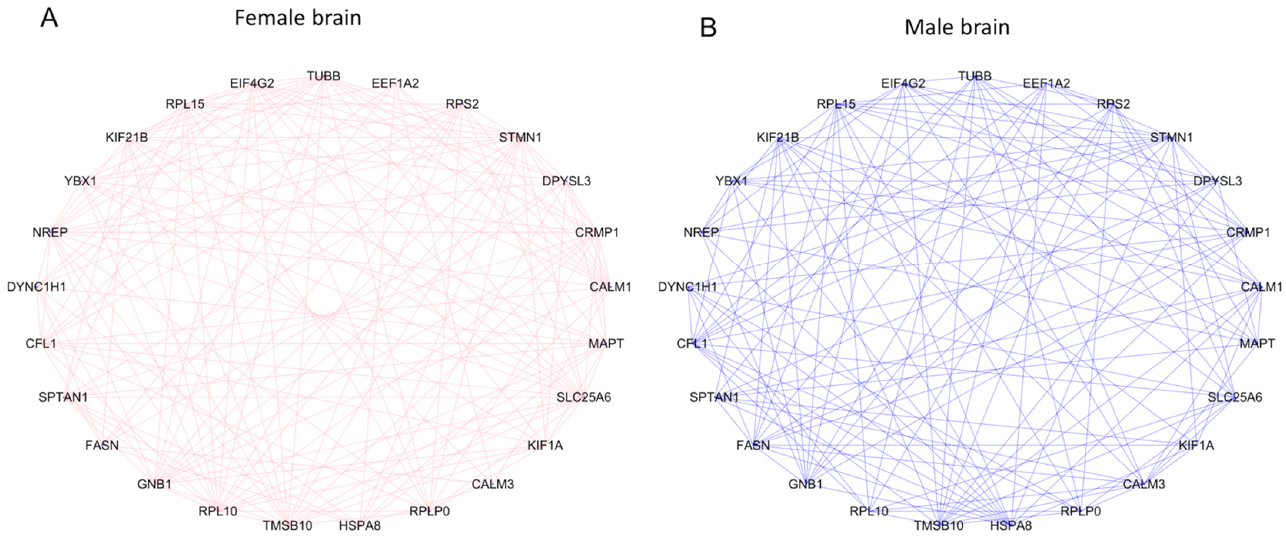
Figure 5. Network plot of genes based on mutation information of expression changes during development of female fetal brain ( A ) and male fetal brain ( B ). The lines (edges) connecting the nodes show how a gene is transcriptionally interconnected with other genes. They are colored pink in female brain and blue in male brain.